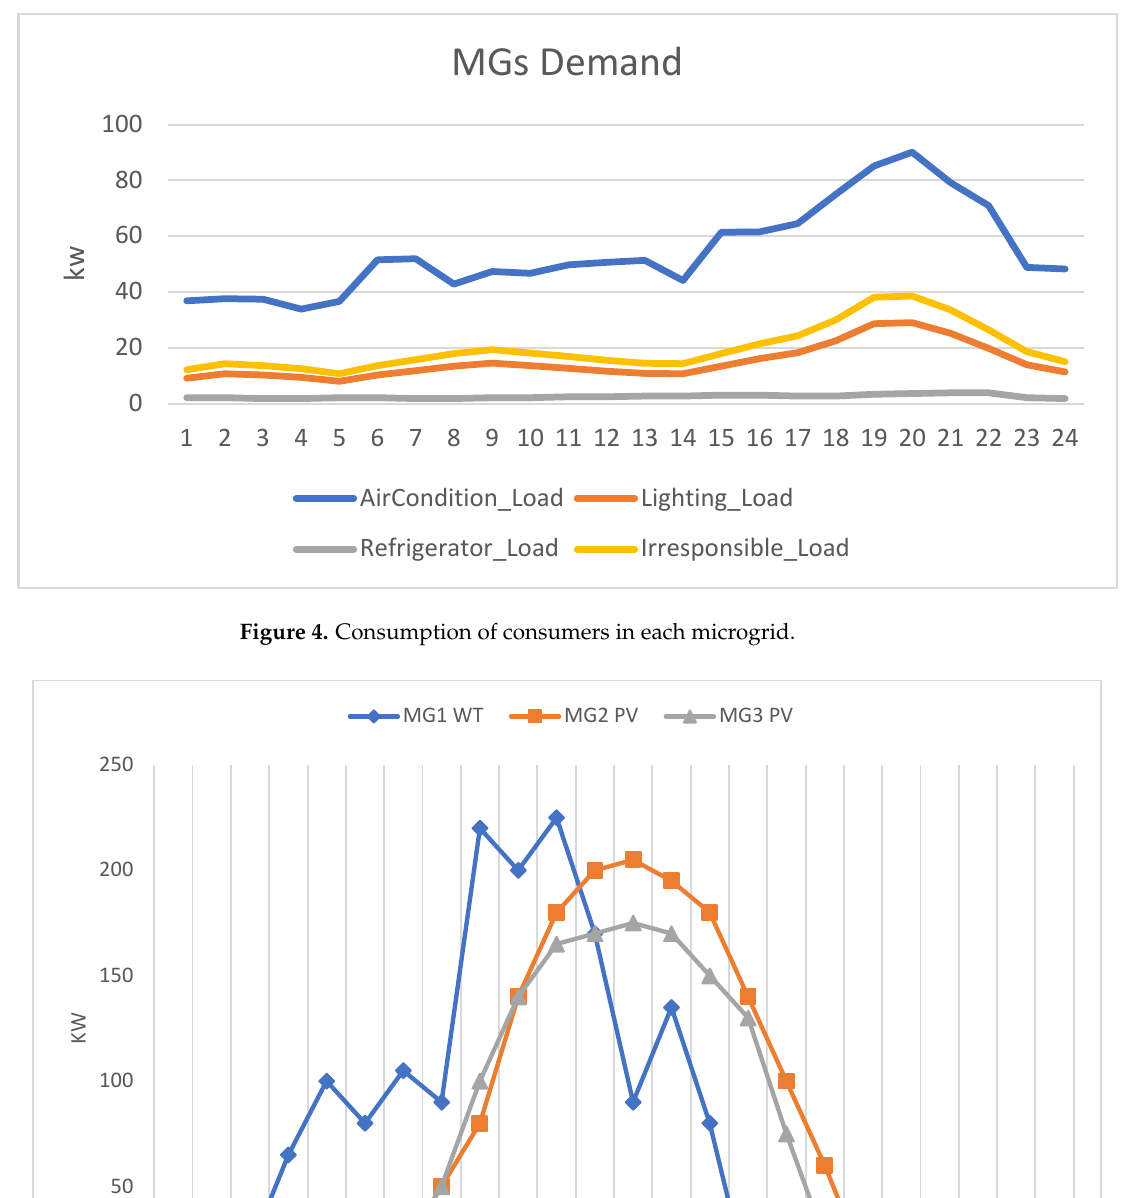
Table 1. Specifications of production units in each microgrid.